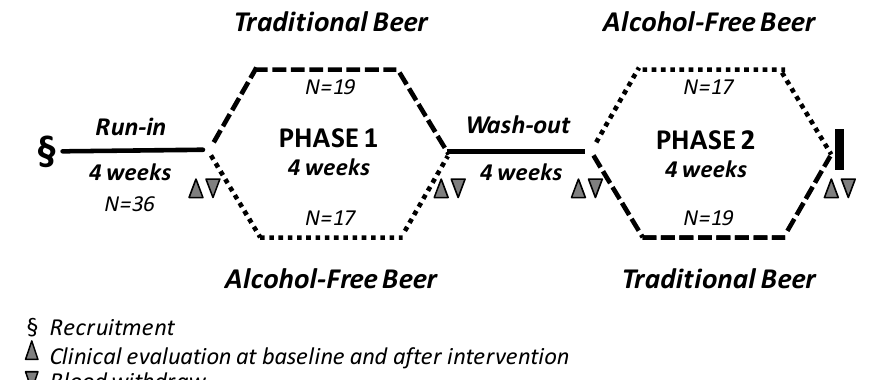
Figure 1. Flow diagram describing the study design.